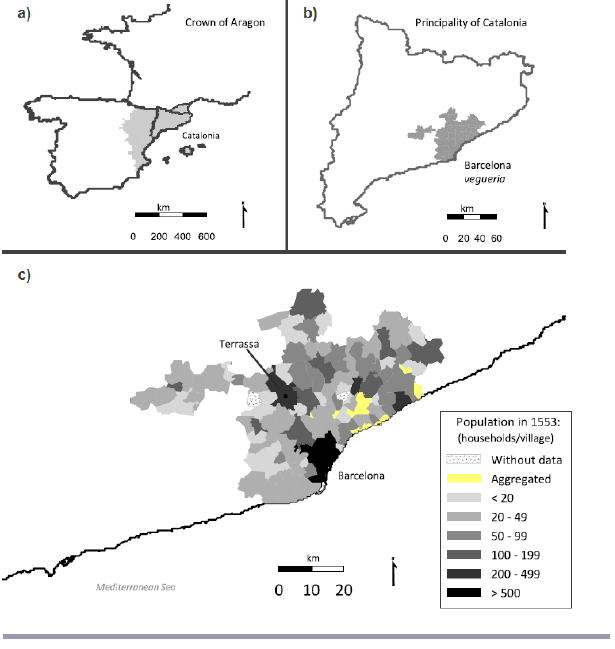
Fig. 1 . Location of the studied community: (a) Crown of Aragon highlighted in gray, with the Principality of Catalonia; (b) Principality of Catalonia, with the Barcelona vegueria highlighted in gray; (c) population from the villages belonging to the Barcelona vegueria. Sources: population data are derived from the household survey of 1553 (Iglésies 1981, CED